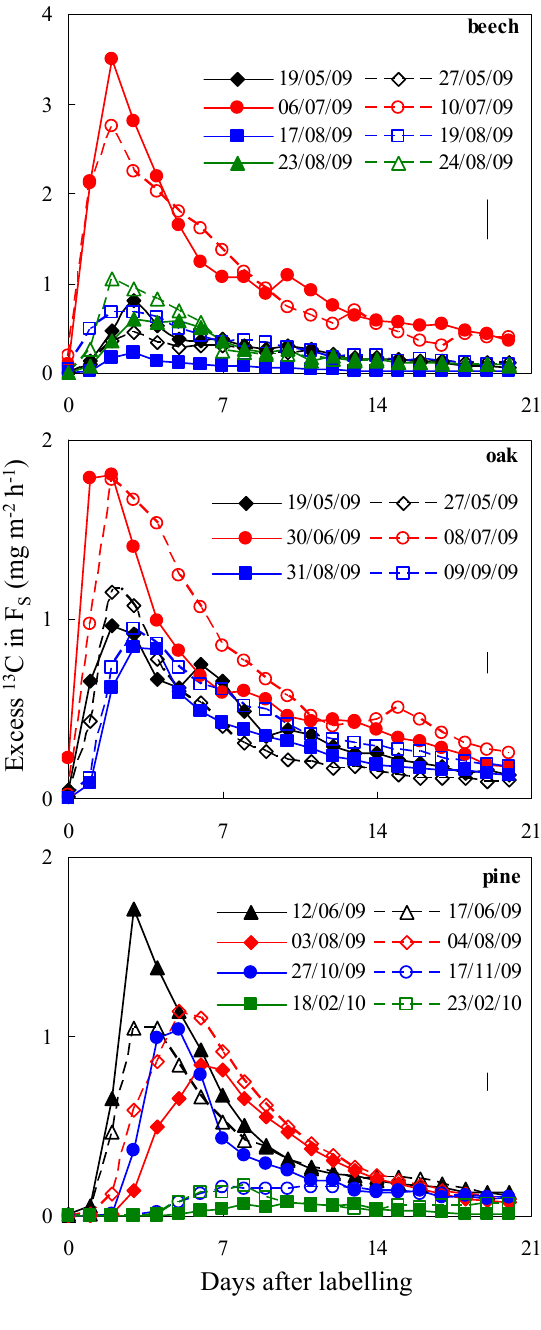
Fig. 2. Time courses of 24h average of Excess 13 C in soil CO 2 efflux ( F S ) after whole crown pulse labelling of beeches (top), oaks (middle) and pines (bottom). Each tree is identified by its date of labelling. There are significant differences between trees ( F 7 , 126 = 41 . 0, F 5 , 63 = 63 . 9 and F 7 , 126 = 114 . 2 for beech, oak and pine respectively, p < 0 . 001) and between sampling dates ( F 160 , 126 = 2 . 75, F 120 , 63 = 14 . 3 and F 160 , 126 = 15 . 8 respectively, p < 0 . 001). The verticals bars represent the root mean